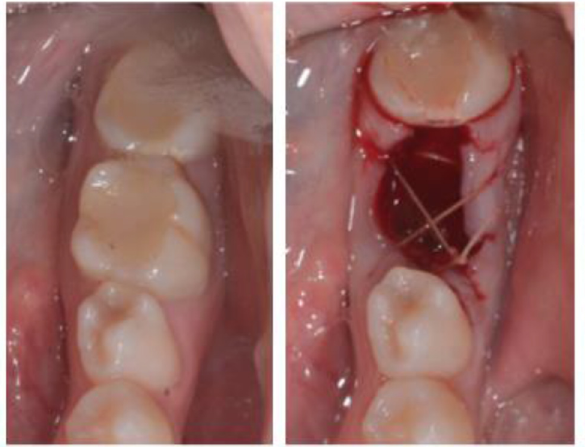
Fig. 4. Intraoral pictures before and after extraction of tooth